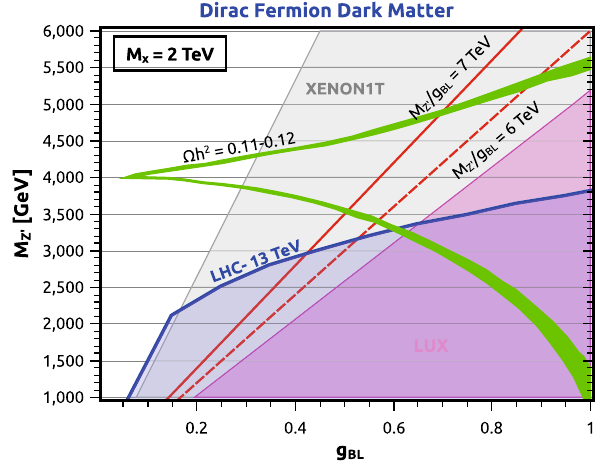
Fig. 10 Allowed region of parameters for a 2 TeV Dirac fermion as darkmatter.The greencurve delimitstheregionofparameterspacewith therightabundance( (cid:2) h 2 = 0 . 11 − 0 . 12),the pink ( gray ) shadedregion is ruled out by LUX2016 (XENON1T), the blue region is excluded by dilepton data from the LHC, and the solid red ( dashed ) lines rep- resent the current (old) LEP-II bounds, namely M Z (cid:2) / g BL > 7 TeV ( M Z (cid:2) / g BL > 6 TeV)